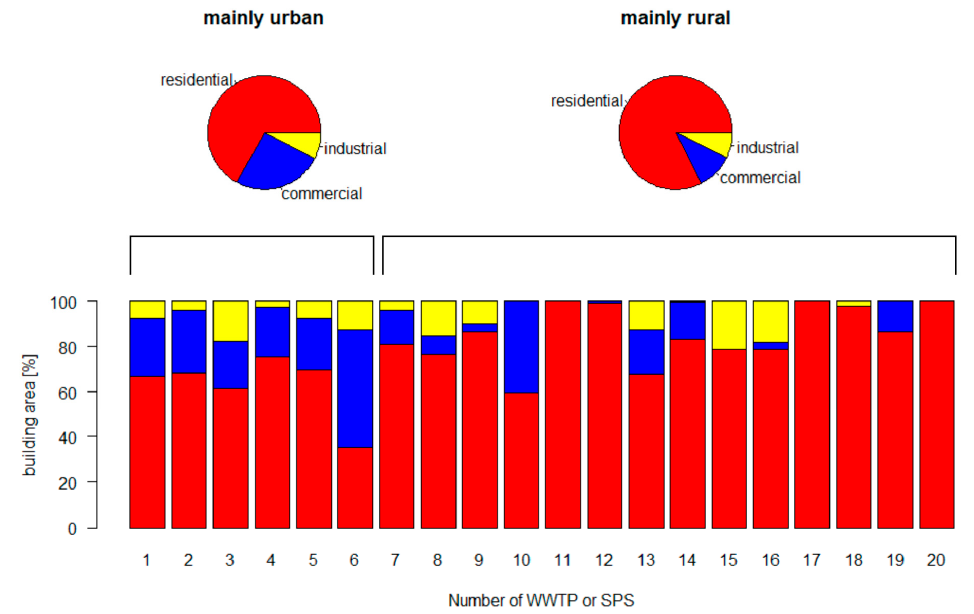
Figure 4. Classification of buildings’ areas in study area by building type.